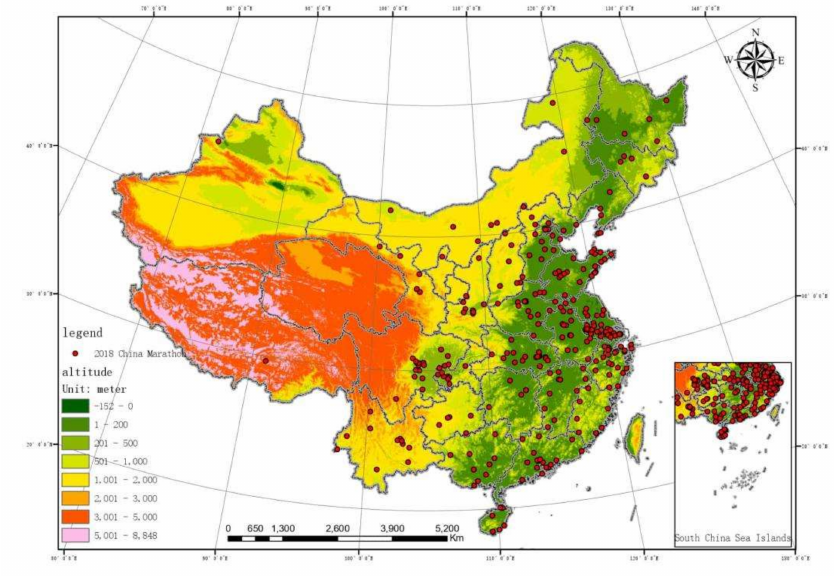
Figure 1. Terrains and marathon running coupling diagram.